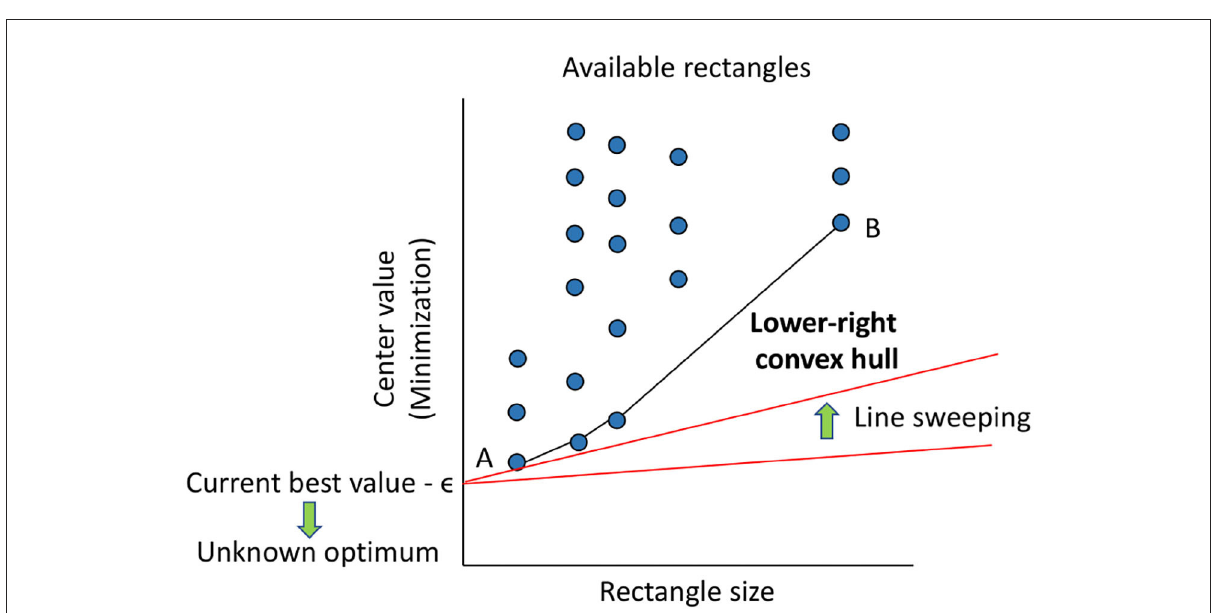
FIGURE5 Selection of rectangles to further explore (divide) in DIRECT for a hypothetical minimization problem. The available rectangles are represented as dots (circles are shown for clarity). The horizontal axis corresponds to the size of each rectangle, and the vertical one shows the value of the objective function at its center (lower is better for minimization). In this context, rectangle A is the one with the best central value, while B encompasses the broadest region. The rectangles selected will lie in the lower-right convex hull, which represents the optimal balance between exploration and exploitation. The red lines at the bottom show an alternative way to derive this selection method: a line is anchored at every value better than known, starting from that one minus the desired accuracy (minimum relevant change), ǫ , and swept upwards until reaching a rectangle. Repeating the process to (negative for minimization) infinity results in the same convex hull (and avoids regions with expected negligible improvements).